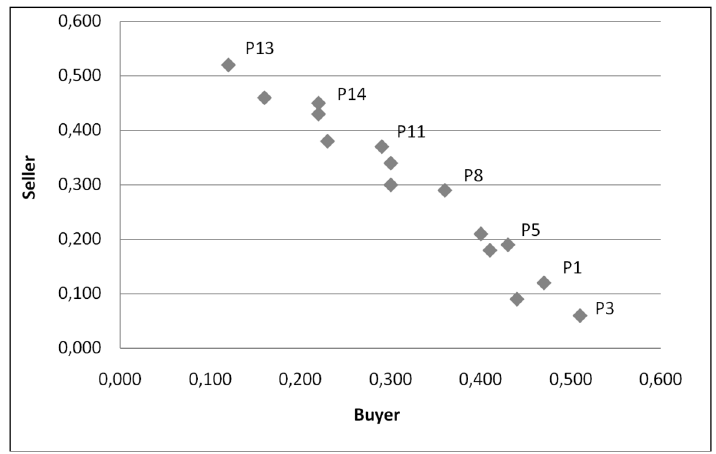
Figure 9. Negotiation packages in the criteria space of the negotiators – SAW procedure for both Seller and